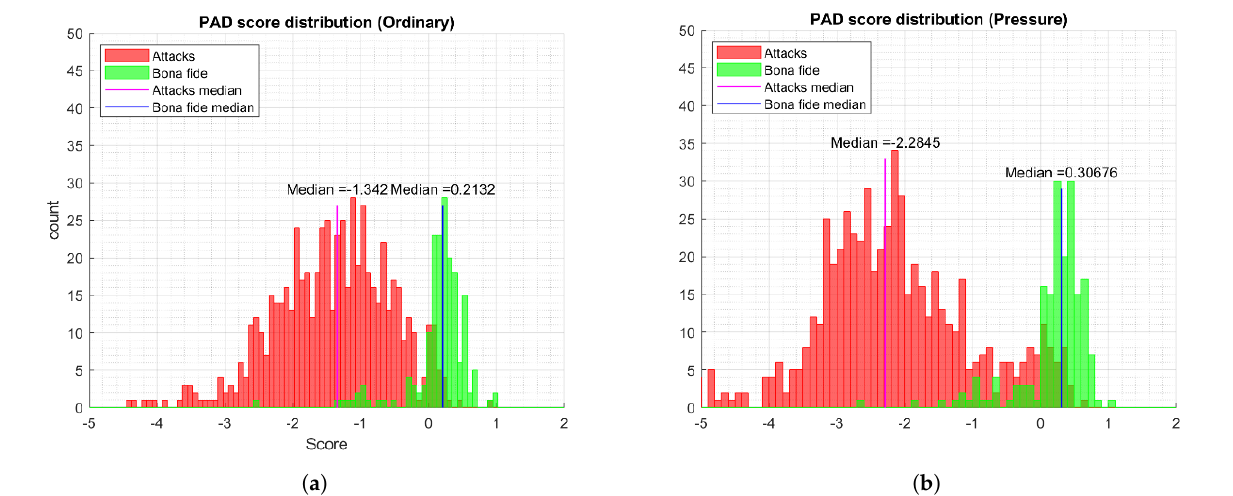
Figure 9. PAD scores distribution for the optical sensor using VLPQ 7×7